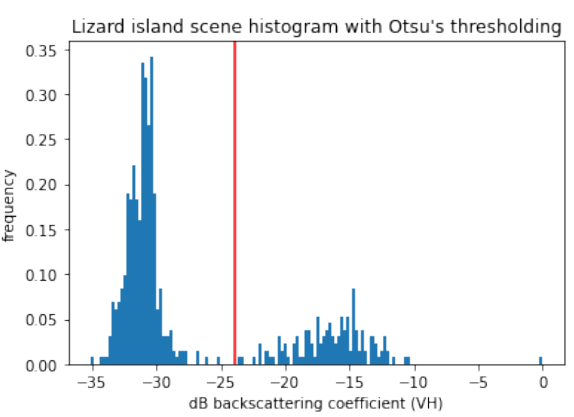
Figure 3. The histogram for the Lizard island scene depicted in the bottom right panel of Figure 2. The result of the Otsu’s method (in red) is equal to -23.95 dB